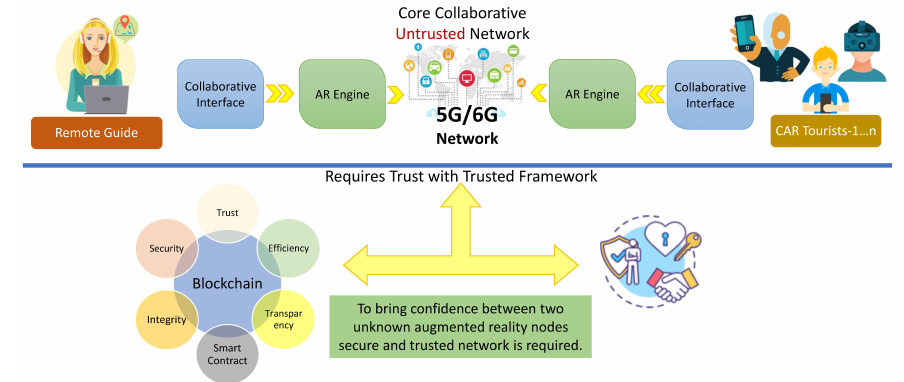
Figure 11. A model of blockchain-based trusted and secured collaborative AR